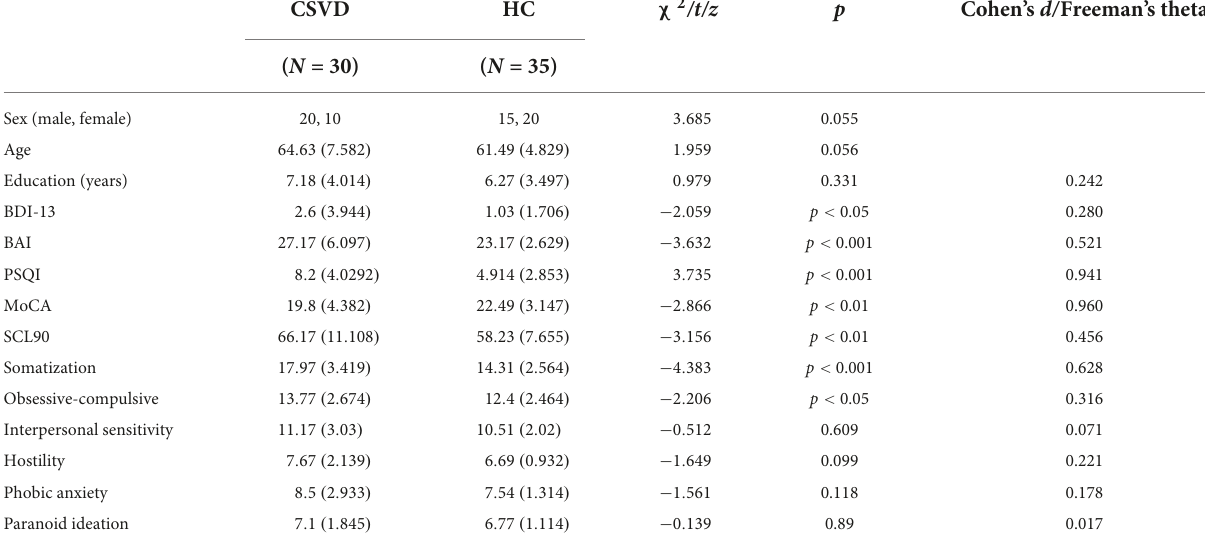
TABLE 1 Demographic information and psychiatric symptoms of the patients with CSVD and healthy controls.